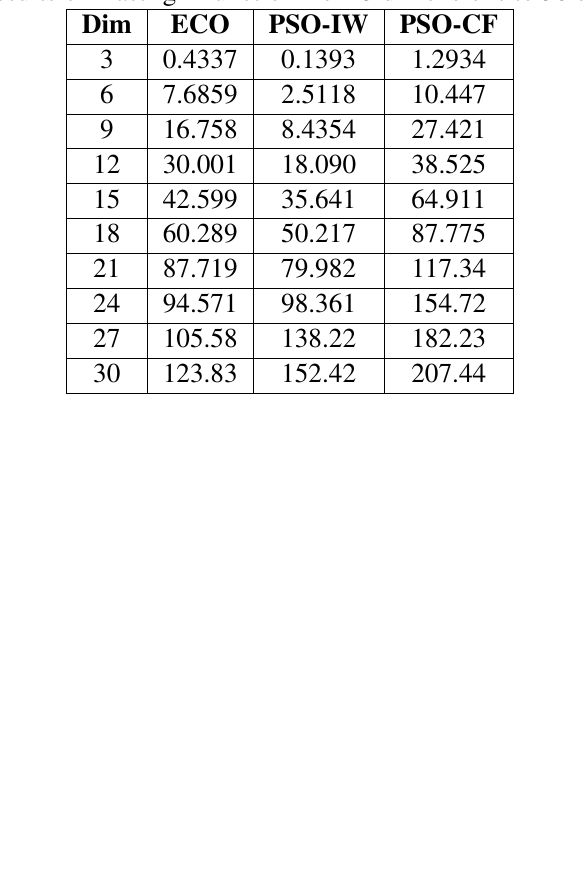
Table 9: Results on Scha ff er’s f6 function under the 2-dimensional space Dim ECO